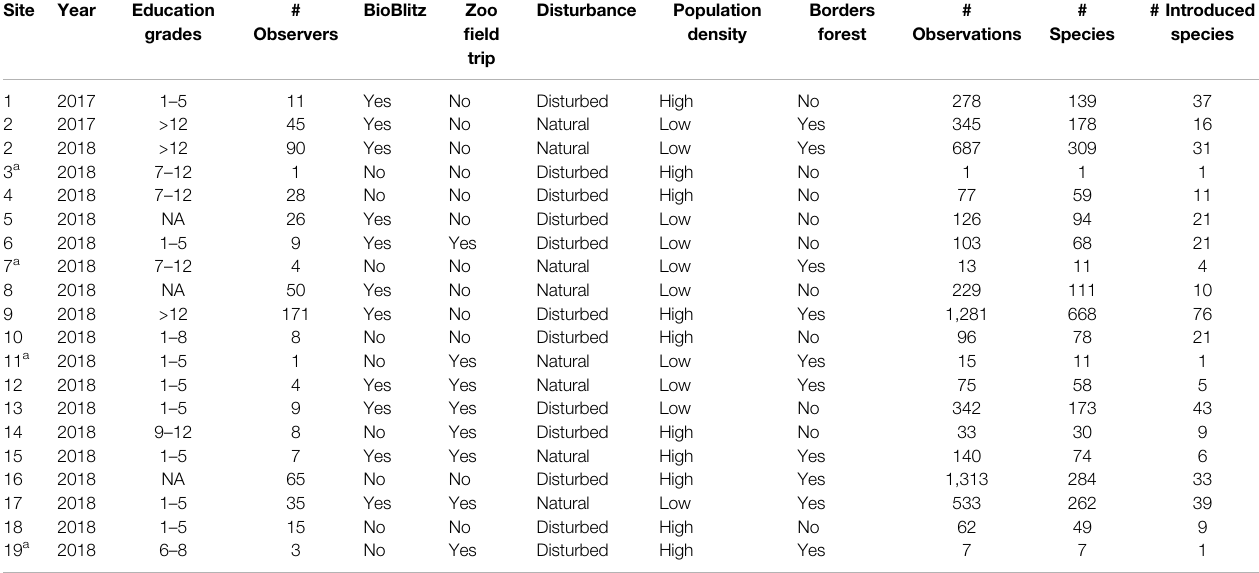
TABLE 1 | Summary information for each site involved in the Tiny North Coast Places project. Information on the observer characteristics, land use characteristics, and summary data are